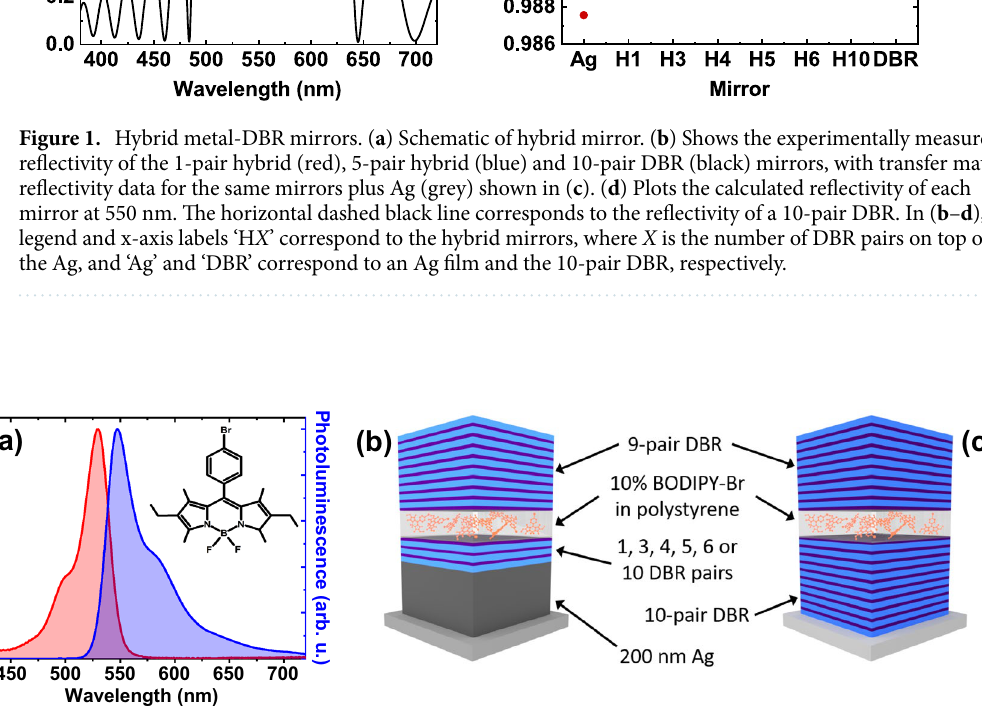
Figure 2. ( a ) Normalised absorption (red) and photoluminescence (blue) spectra of BODIPY-Br at 10% by mass in polystyrene. The molecular structure is shown in the inset. Schematic of ( b ) the hybrid Ag-DBR microcavity and ( c ) a conventional DBR–DBR